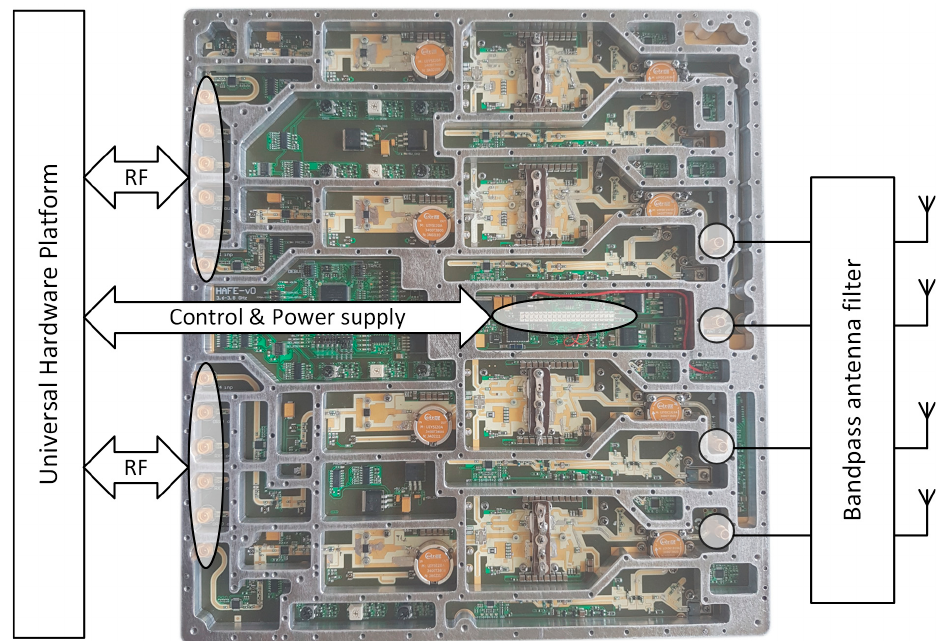
Figure 5. Prototype of the 4-channel RF front-end for the LTE band B43 (PCB dimensions: 30 × 33 cm).